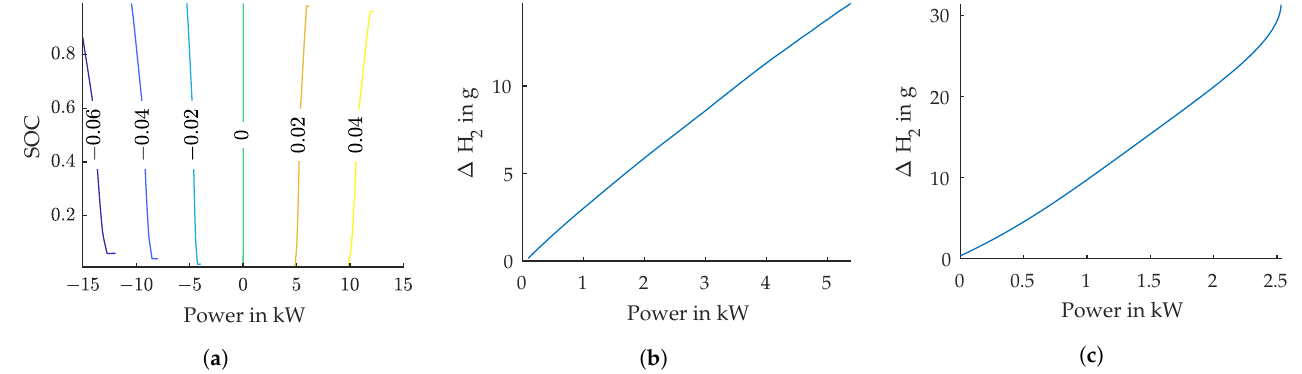
Figure 10. Component models including converter losses. ( a ) Battery: ∆ SOC look-up table. ( b ) Electrolyzer: ∆ H 2 look-up table. ( c ) Fuel cell: ∆ H 2 look-up table. Table 2. H 2 model